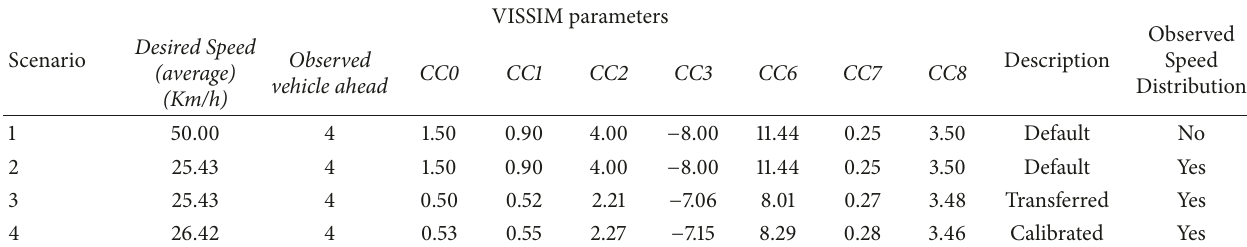
Table 8: Scenario parameters for transferability investigation.